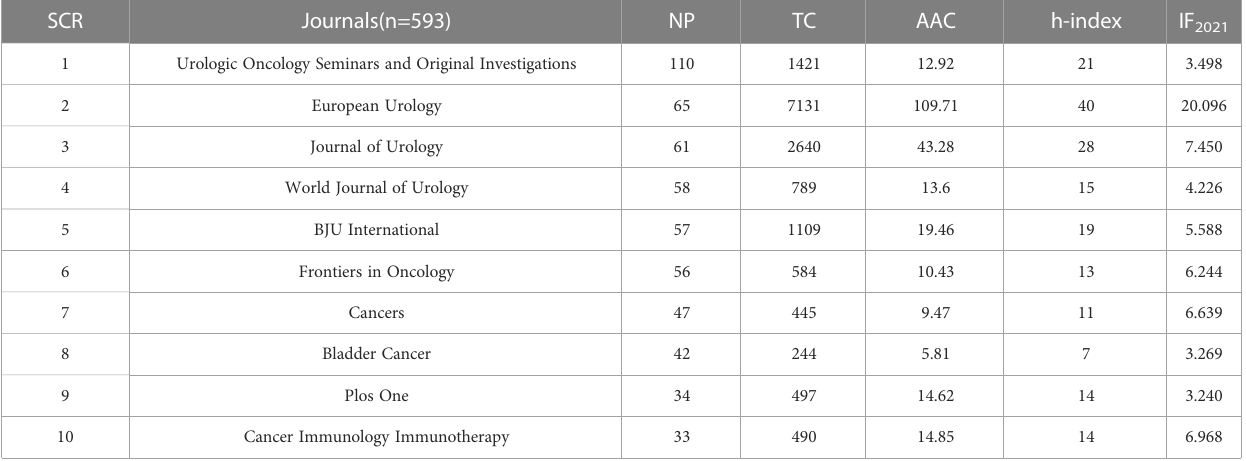
TABLE 2 Top 10 productive